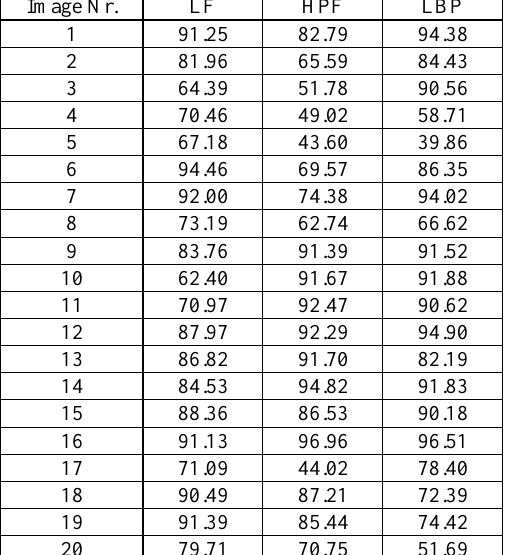
Table 1. Percentage of crack detection completeness regarding to LF, HPF and LBP